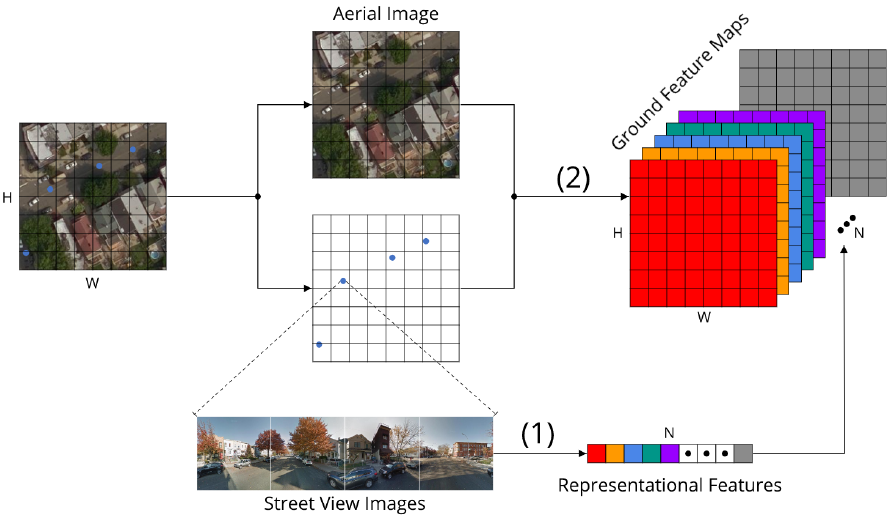
Figure 2. Construction of ground feature maps. (1) Semantic feature extraction; (2) Spatial